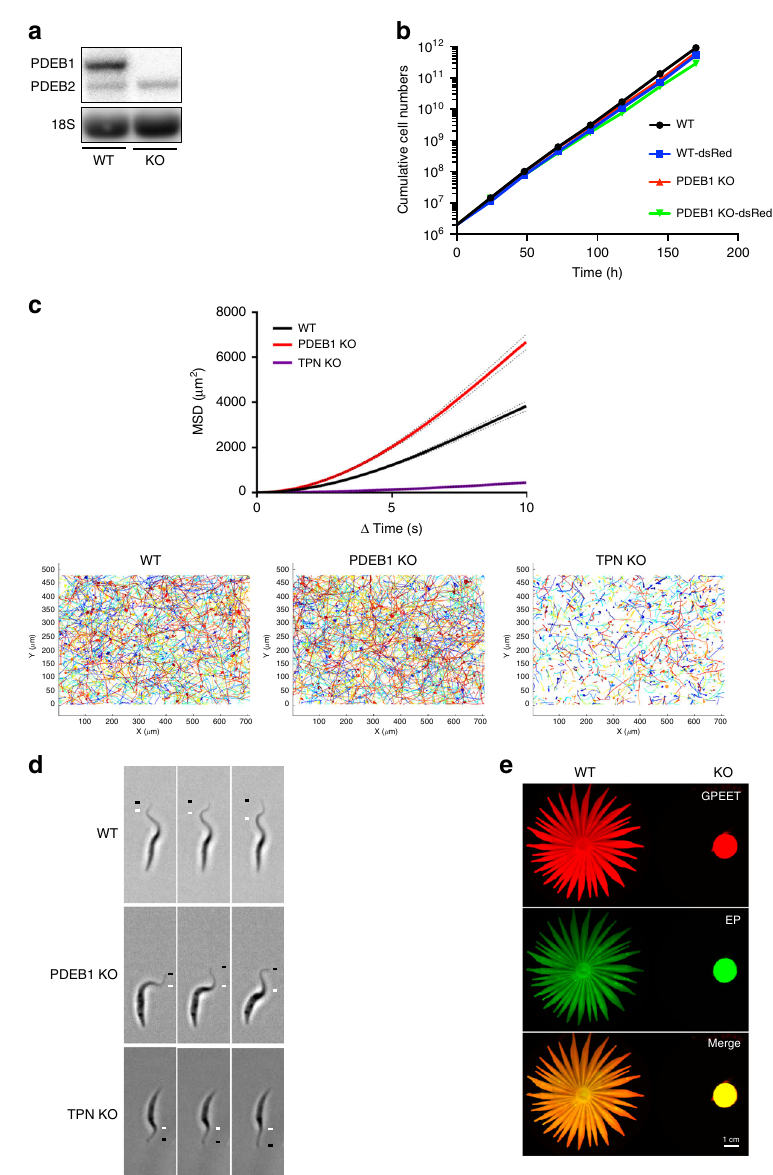
Fig. 2 Effect of PDEB1 knockout on SoMo, growth and motility. a Northern blot analysis of RNA prepared from wild-type parental cells (WT) or PDEB1 knockout cells (KO). Blots were hybridized with a probe corresponding to the coding region of PDEB1. PDEB2 is 93% identical to PDEB1 and the probe cross-hybridizes weakly under the conditions used. 18S rRNA serves as a loading control 66 . b Comparison of population doubling times of WT, KO, WT- dsRed, and KO-dsRed cell lines in suspension culture over the course of 7 days. Cell densities were adjusted daily to 3 × 10 6 cells ml − 1 in order to ensure logarithmic growth. c Mean-squared displacement (MSD) is measured for WT, PDEB1 KO, and trypanin knockout (TPN KO) cells. Results are from three biological replicates and a total of n = 1449 cell traces for WT, n = 1339 cell traces for KO, and n = 1208 cell traces for TPN KO from a total of 34 videos for each. Dotted lines represent standard error of the mean (SEM). Cell traces from the 34 videos are superimposed over each other for WT, PDEB1 KO, and TPN KO, respectively. d Still images from high-speed videos of WT, PDEB1 KO, and TPN KO cells taken at 496 frames per second under x20 magni fi cation. Each series of images shows one cell per genotype at six millisecond intervals. The black line indicates the fl agellum tip, and the white line indicates the peak of the fl agellar wave. See supplemental information for Supplementary Movies 1 – 3. e Social motility assays were performed with WT and KO cells. Community lifts 36 were performed and incubated with anti-EP (green) and anti-GPEET (red) have detrimental effects on growth or motility of procyclic forms The T. brucei genome encodes fi ve PDEs: PDEA, PDEB1, in liquid culture 33 . PDEB2, PDEC, and PDED. PDEA is neither essential for Evidence for a role of cAMP beyond parasite viability has come bloodstream or procyclic forms, nor is it required for fl y midgut from studies of collective cell motility 25,34 . When early procyclic infection 32 . RNAi knockdown of PDEB1 and PDEB2 together is lethal in bloodstream form trypanosomes, but knockdown of forms are cultured on a semi-solid surface, they exhibit a type of either protein alone does not affect viability 33 and their role in coordinated group movement termed social motility (SoMo) in which the parasites assemble into groups that sense signals from trypanosome biology, beyond being essential, is unclear. Knock- other cells and alter their movement in response 35,36 . Genetic or down of PDEB1 and PDEB2, singly or in combination, does not